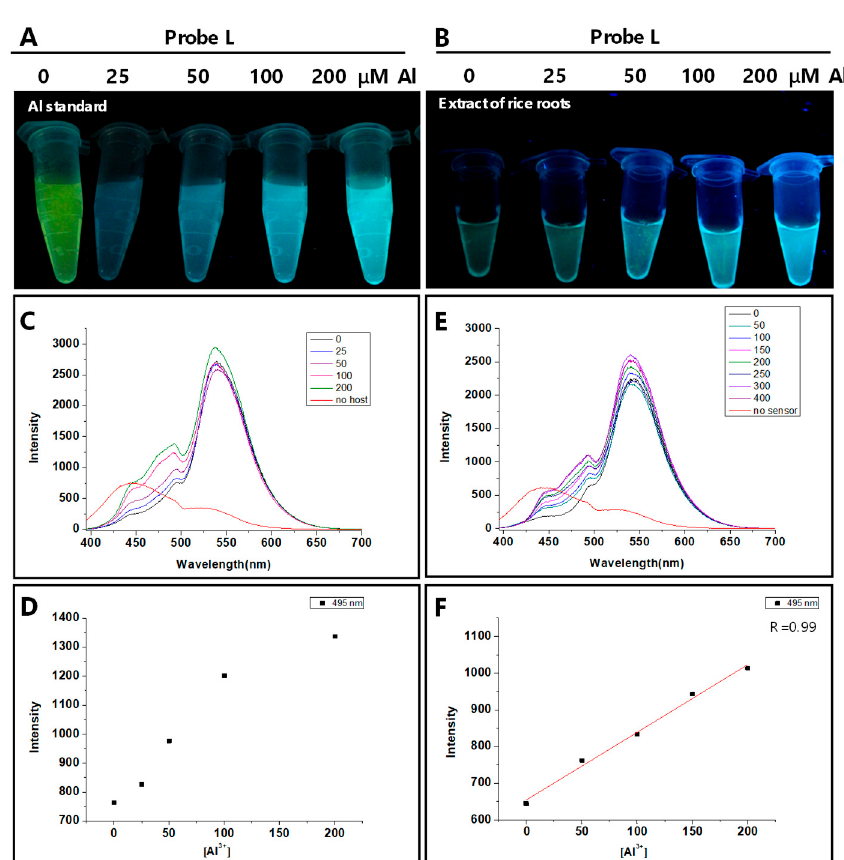
Figure 8. Quantitative determination of Al concentrations in rice seedlings. ( A ) Fluorescence probe L with the addition of various concentrations of Al(ClO 4 ) 3 solution (0, 25, 50, 100, and 200 µ M) was excited by a handheld UV lamp with 345 nm excitation. The blue emission was photographed immediately in the dark. ( B ) Fluorescence probe L with the addition of rice extracts on treatment with various concentrations of Al 3+ . The samples were excited by UV, and blue emission was photographed. ( C ) Measurement of fluorescence intensity of probe L at 495 nm with the addition of rice extracts on treatment with various concentrations of Al 3+ . All data were measured after 20 min nm. ( D ) Fluorescence values corresponding to each treatment in (C) were plotted. ( E ) Measurement of fluorescence intensity of probe L with increasing concentrations of Al 3+ standards (0, 50, 100, 150, 200, and 300 µ M) dissolved in control seedling extracts. ( F ) A linear calibration curve was constructed on the basis of fluorescence intensity and Al 3+ standards. Three replicates were performed with nearly identical results.